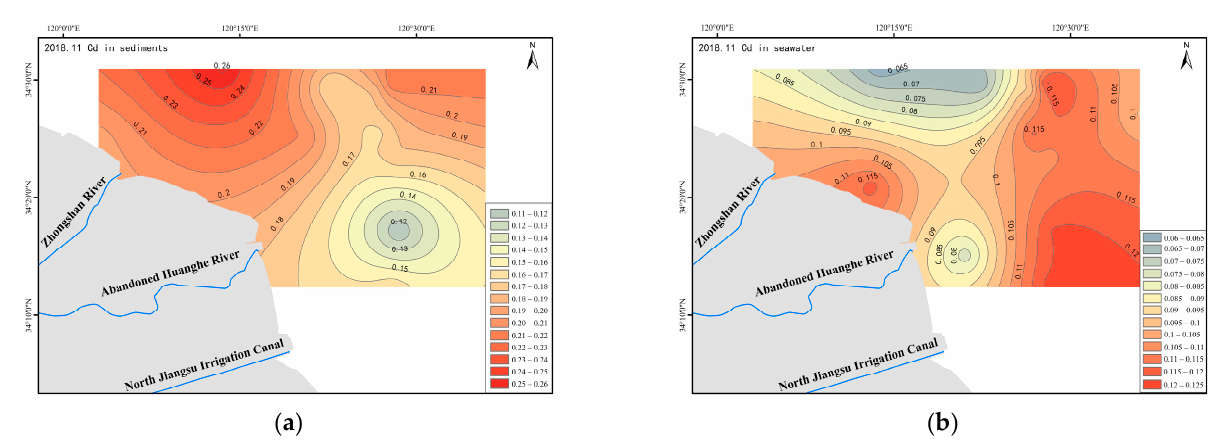
Figure 14. Spatial distribution of Cd in the sediment ( a ) and seawater ( b ) in 2018.